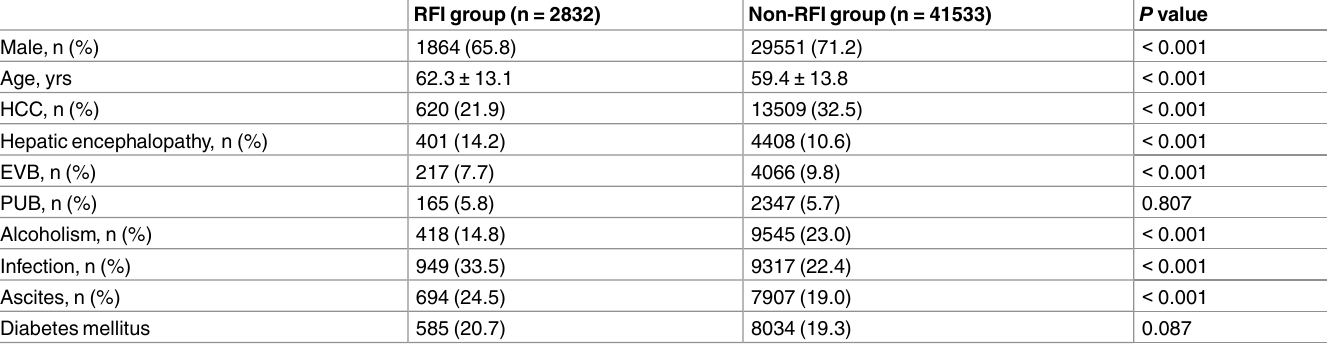
Table 1. Demographic characteristicsof cirrhoticpatientswithand withoutrenalfunctionimpairment. RFI group (n =